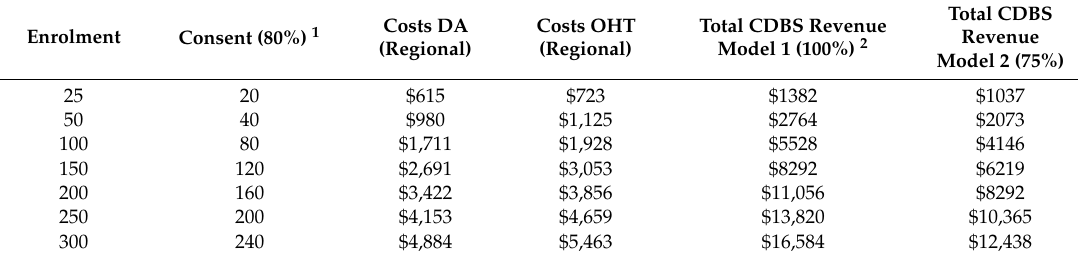
Table 5. Revenue modelling to support a school-based fluoride varnish